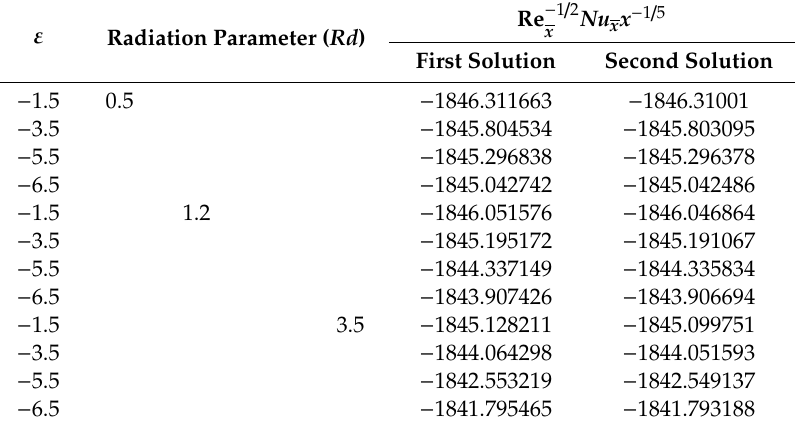
Table 3. The effect of the radiation parameter ( Rd ) on the reduced local Nusselt number when 0 0.5,